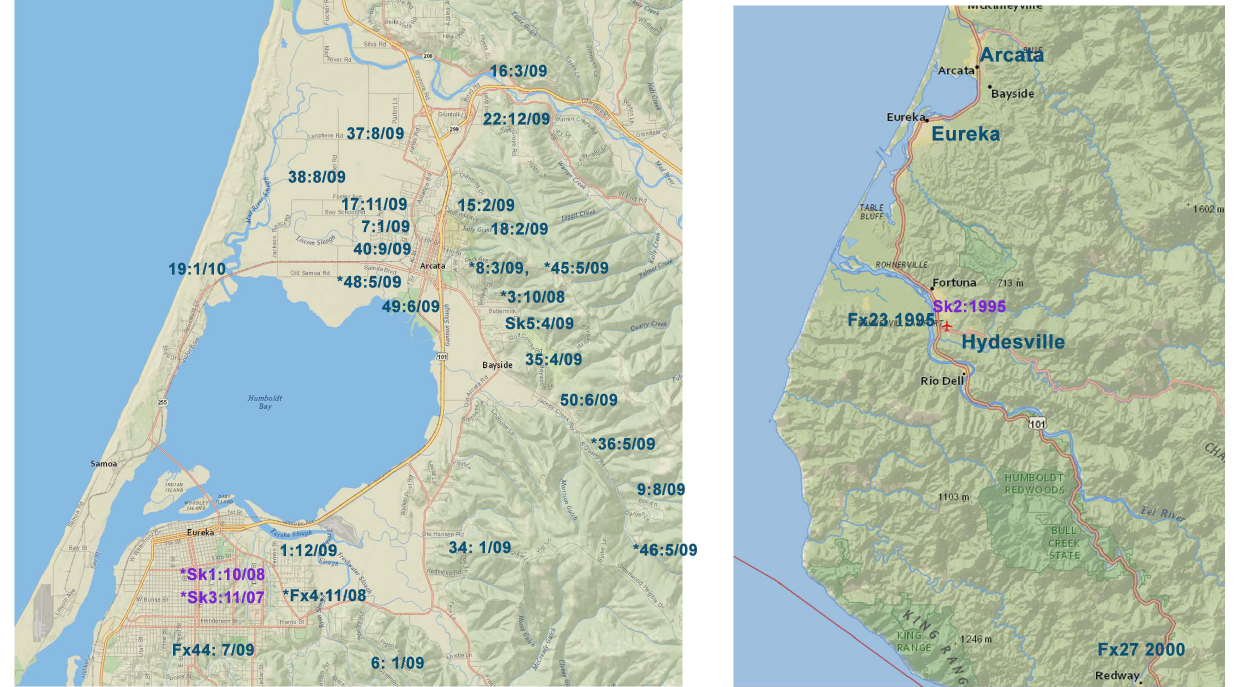
Figure 2. Map of Humboldt Co. showing date and location of rabies samples. Left hand map shows outbreak region, right hand map shows location of pre-outbreak samples. Fox samples are labelled using sample number and collection date. Skunk sample numbers are preceded by ‘‘Sk’’. Sample numbers marked with an asterisk indicate exact address of the sample was not available or ambiguous.